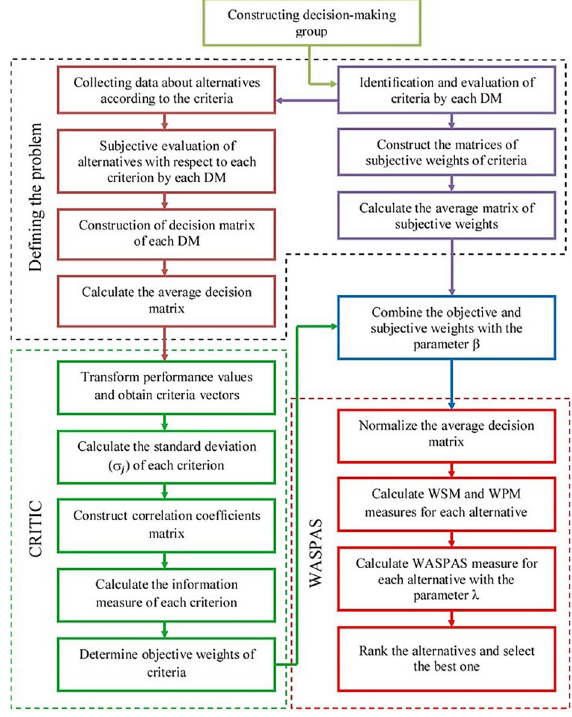
Fig. 2. The framework of the proposed